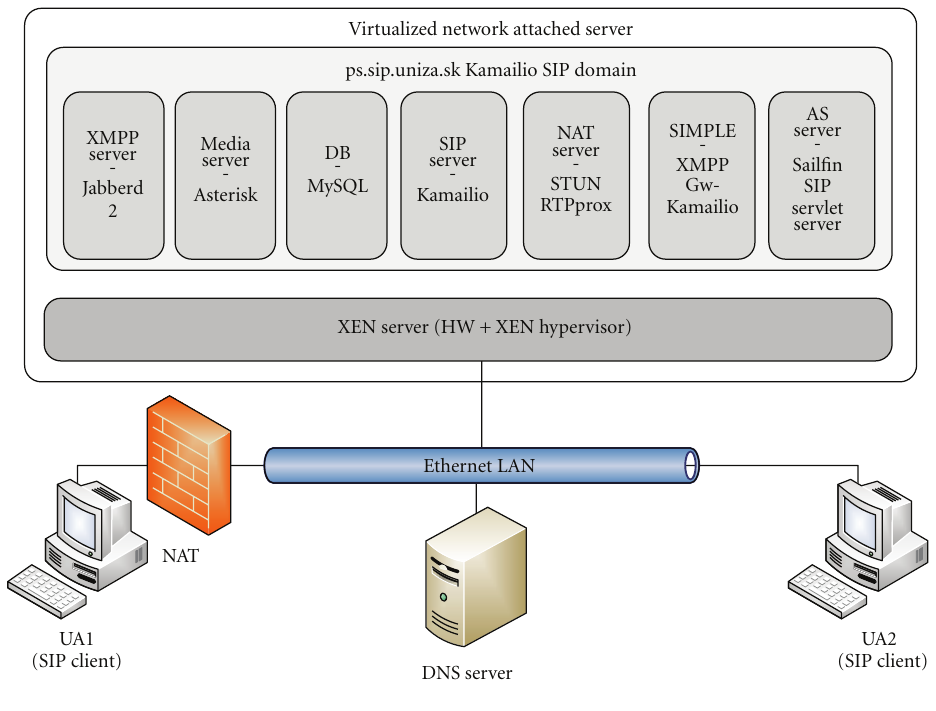
Figure 7: Proposed